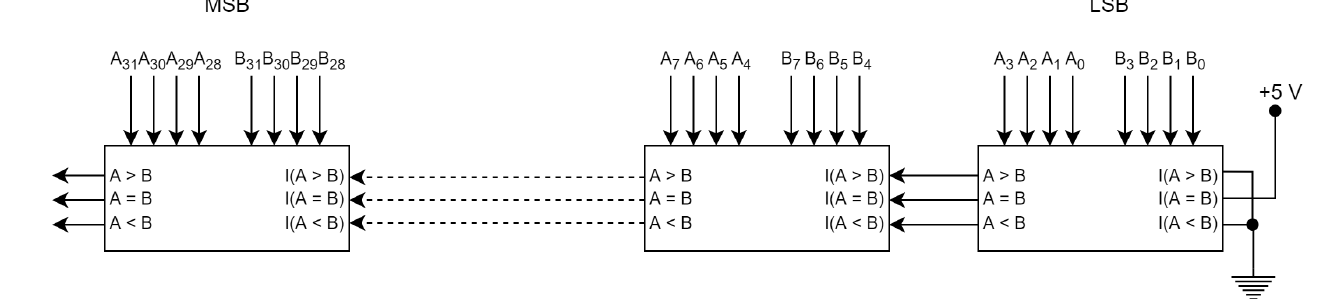
Figure 2. A 32-bit comparator circuit by cascading 4-bit IC 7485